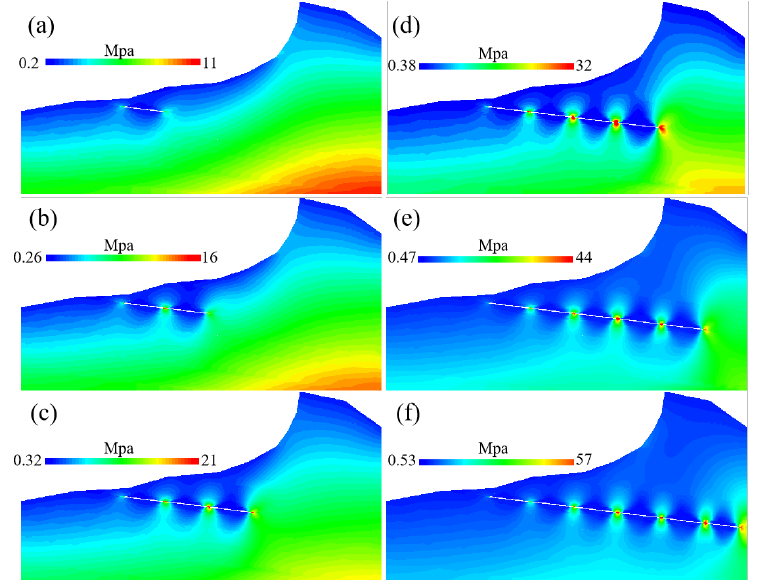
Figure 12. Vertical stress distribution: ( a ) simulation of stress change after the 1st mining; ( b ) sim- ulation of stress change after the 2nd mining; ( c ) simulation of stress change after the 3rd mining; ( d ) simulation of stress change after the 4th mining; ( e ) simulation of stress change after the 5th mining; ( f ) simulation of stress change after the 6th